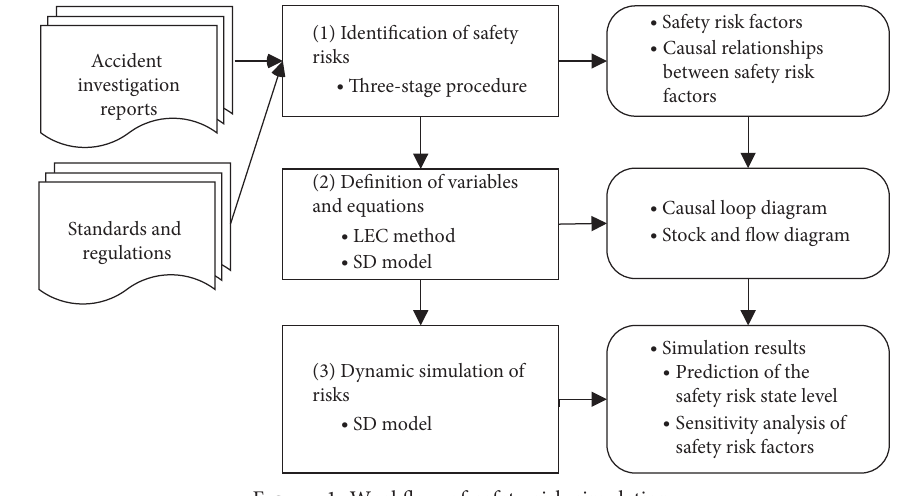
Figure 1: Workflow of safety risk